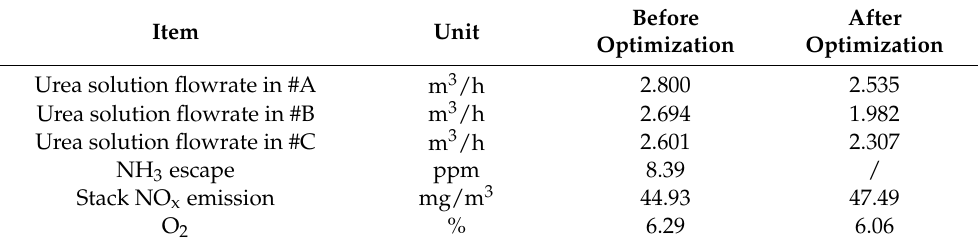
Table 6. Main operating parameters of SNCR process during urea optimization. Item